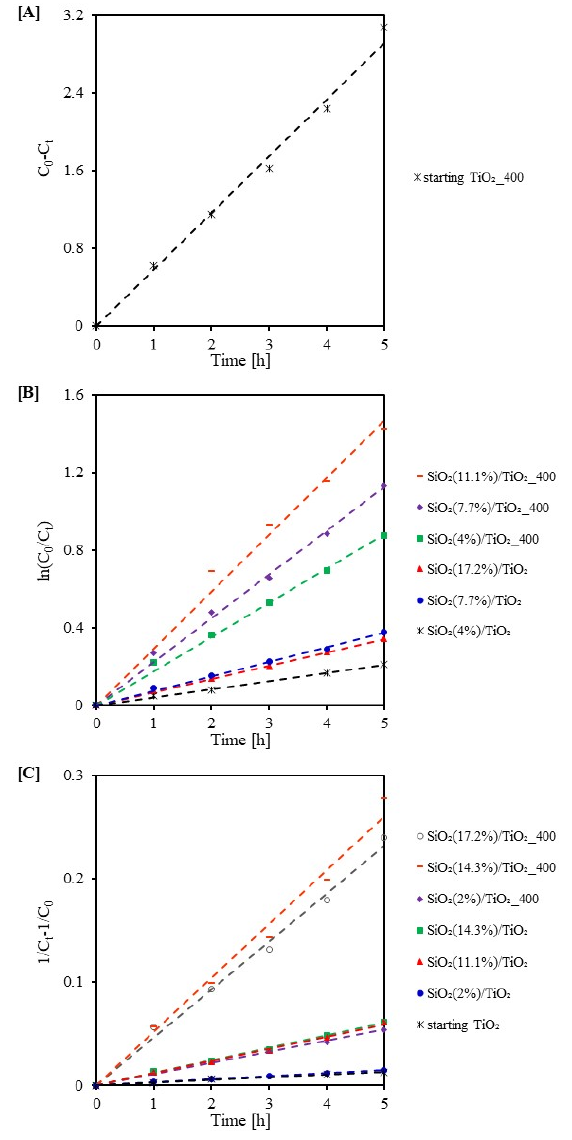
Figure 10 . The zero-order plot ( A ), the pseudo-first-order ( B ), and the pseudo-second-order plot ( C ) of methylene blue decomposition.